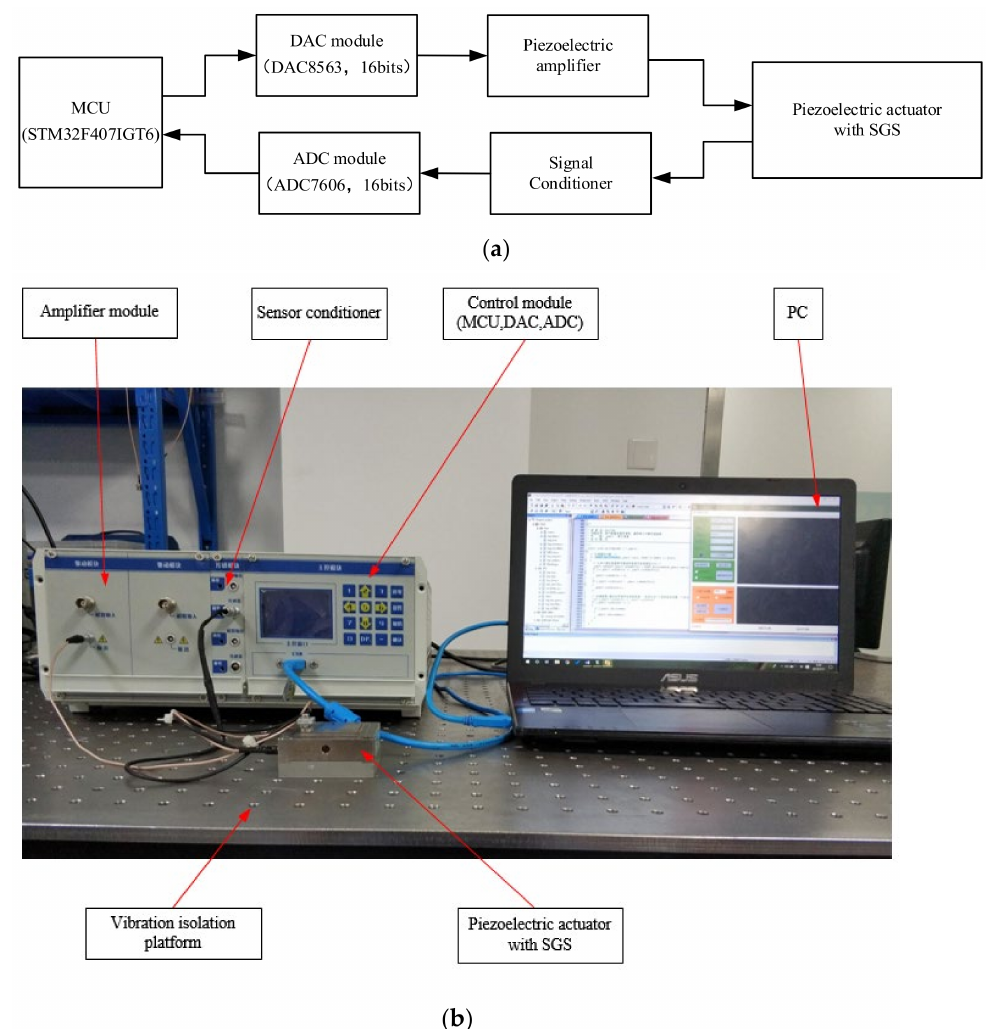
Figure 12. Experiment system for PZA. ( a ) Schematic of experiment system. ( b ) Picture of experi- ment